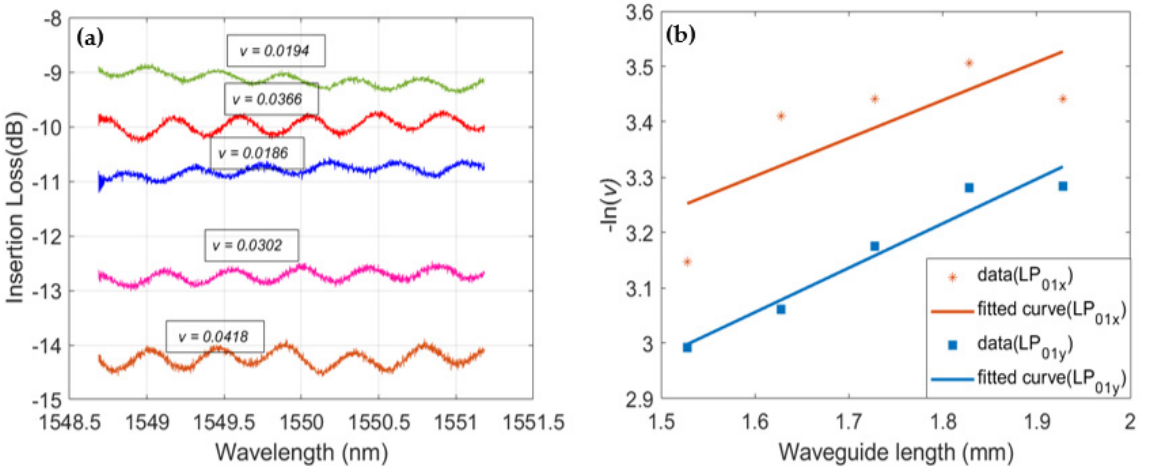
Figure 11. ( a ) Measured insertion loss variation of five identical waveguide samples of equal total length (1728 µm). ( b ) Loss regression analysis for estimation of waveguide propagation loss.